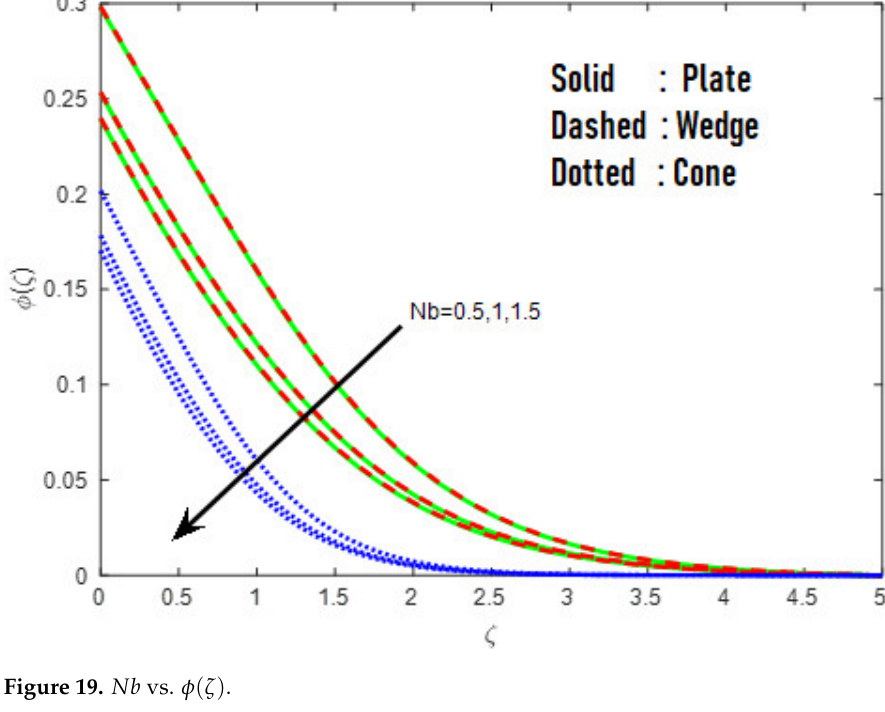
Figure 19. Nb vs. Figure 19. Nb vs. φ ( ζ ) .